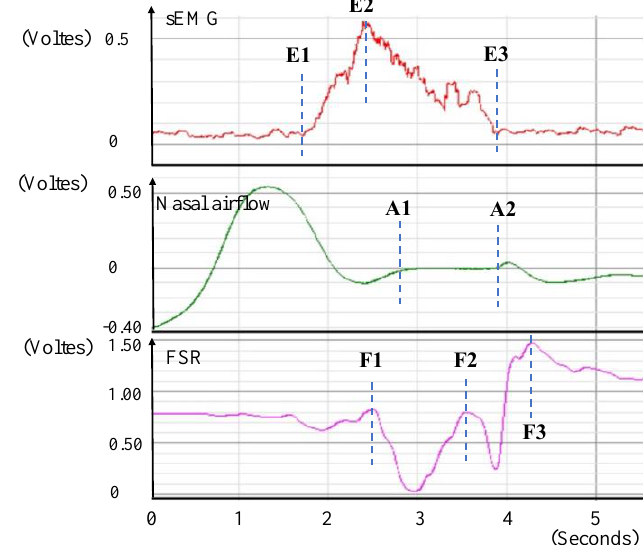
Figure 2. Swallowing and respiration signals from three sensors. Table 1. Variables about the respiration and swallowing